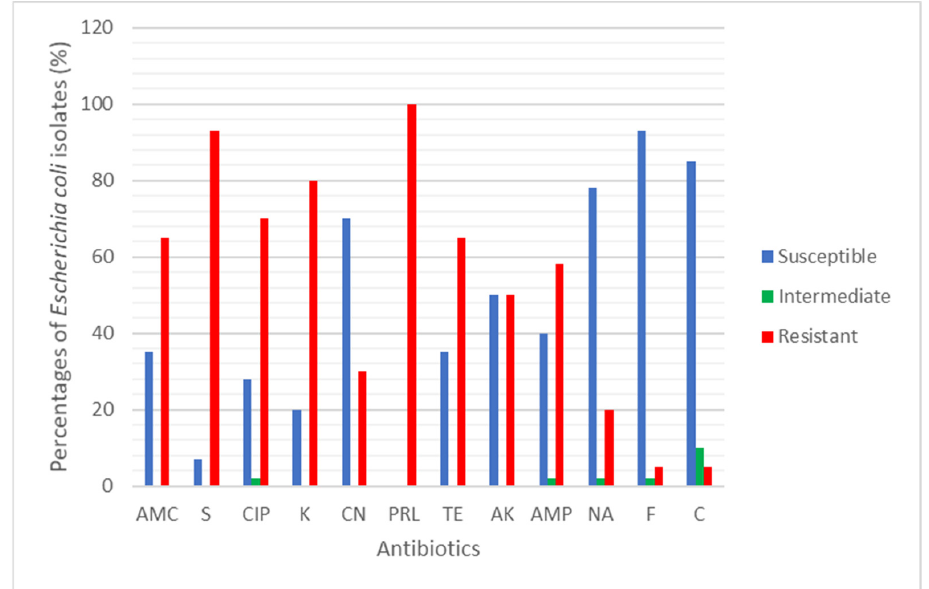
Figure 2. The percentage (%) of Escherichia coli isolated from 6 Sarawak rivers that showed Susceptible, Intermediate and Resistant against the 12 antibiotics tested.